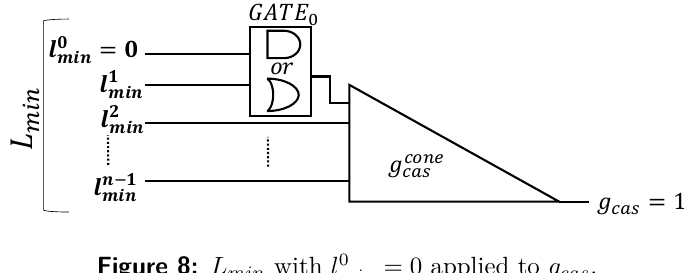
Figure 8: L min with l 0